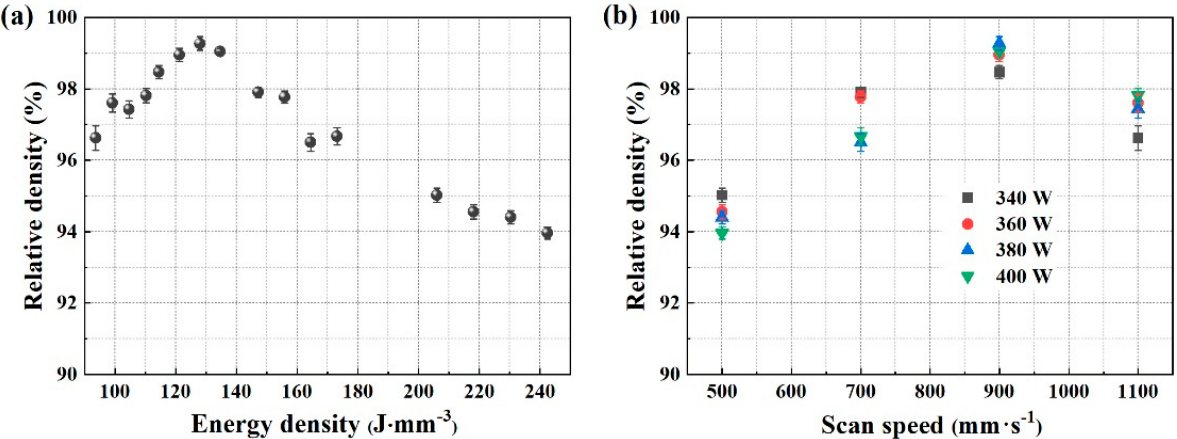
Figure 2. Densification of cubic samples with different process parameters: ( a ) volume energy den- sity; ( b ) laser power and scanning speed.